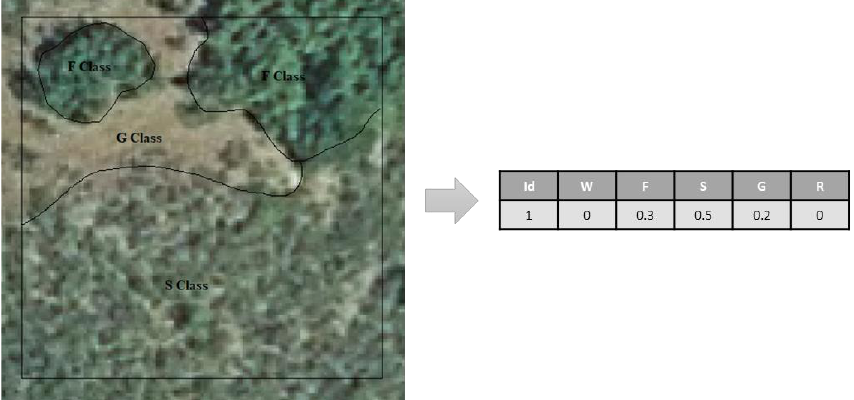
Figure 5. Procedure for obtaining reference fractions from the sample of the 30 × 30 m plots for validation. By assigning an identifier to each entity, the fractions of each type of existing habitat were visually identified.